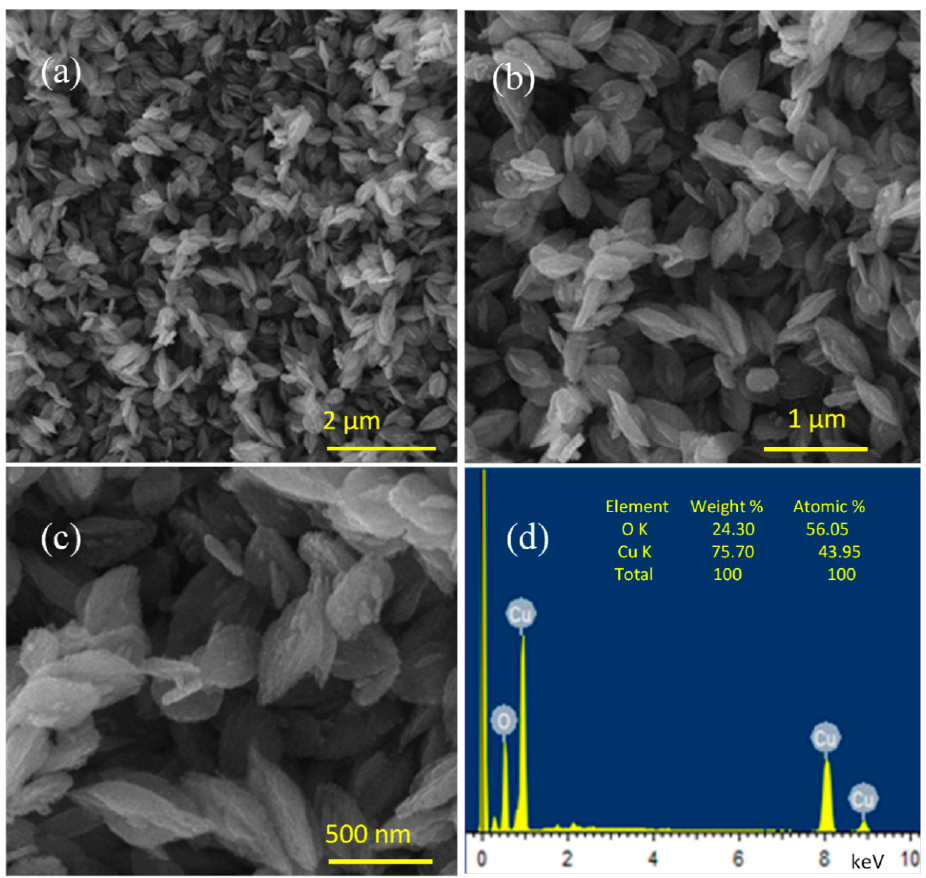
Figure 1. Field emission scanning electron microscope ( FE-SEM) images of monodispersed CuO